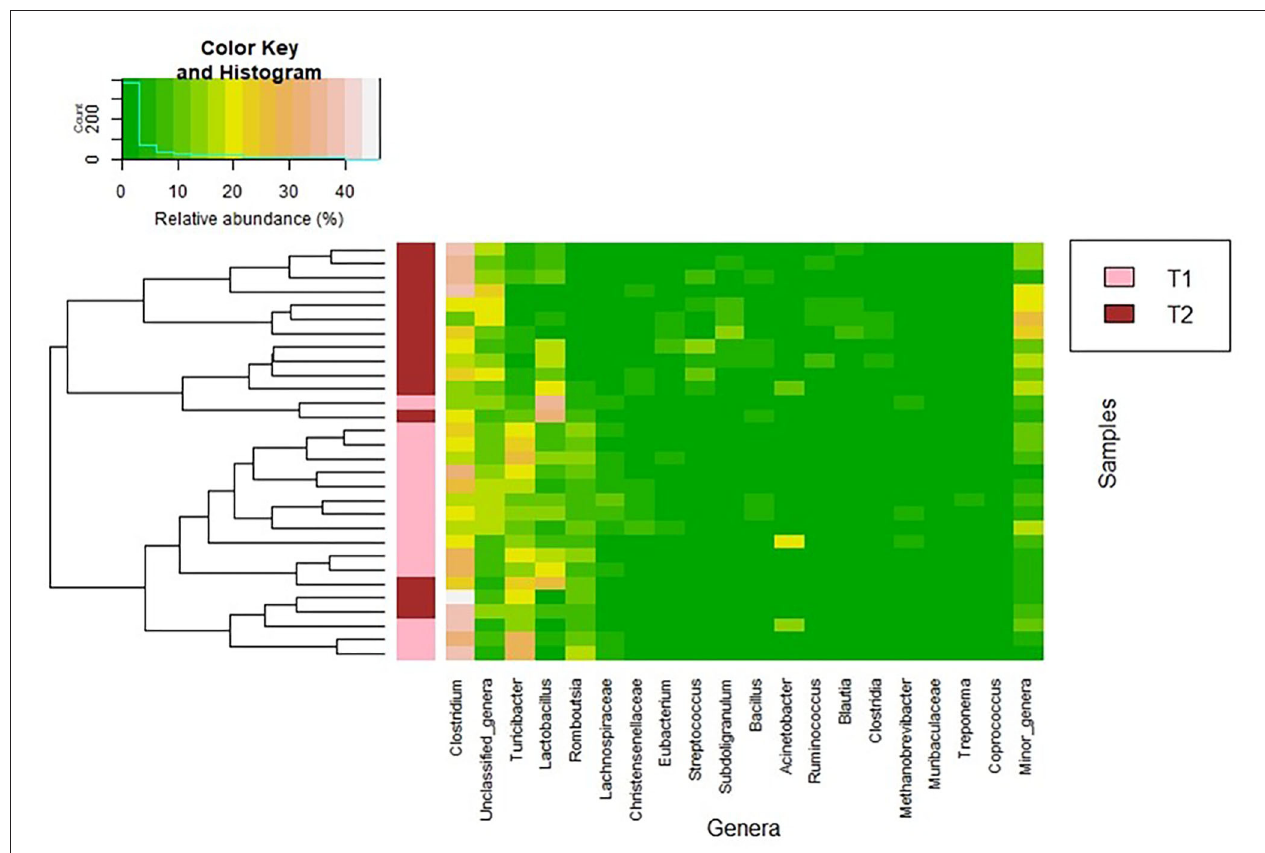
FIGURE 2 | Heatmap showing the relative abundance of the 20 most abundant bacterial genera (x axis) detected in the fecal samples. The relative abundance of each bacterial genus within each sample is indicated by the color of the scale ranging from white (high relative abundance) to green (low relative abundance) as indicated in the scale shown at the left upper corner. Dendrogram linkages are based upon relative abundance of the genus within the samples and hclust was used as the clustering algorithm. The column between the dendrogram of the fecal samples and the individual values of the relative abundance of bacterial genera indicates the group of samples (T1 and